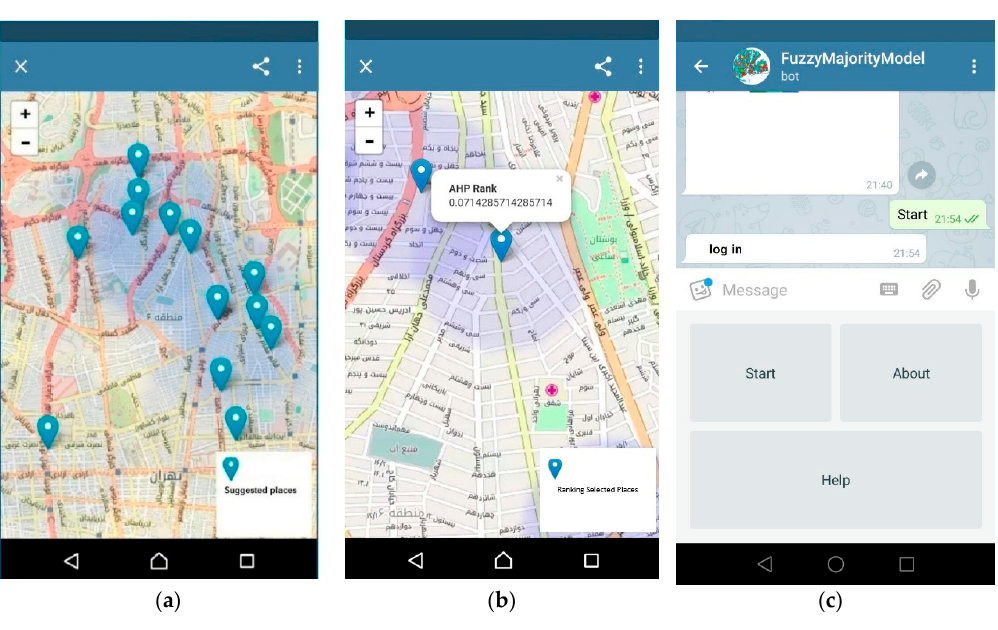
Figure 6. The sequence of system performance: ( a ) suggested options; ( b ) the output stage individual decision; and, (c) System manager panel.